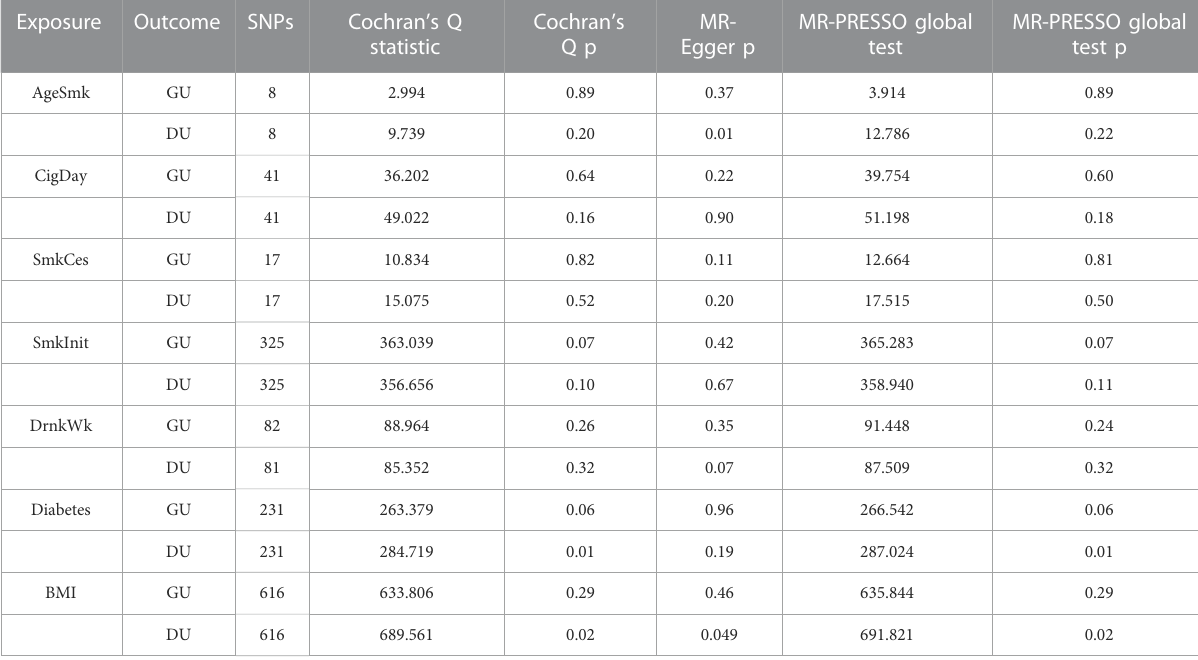
TABLE 3 Potential pleiotropy evaluation using different